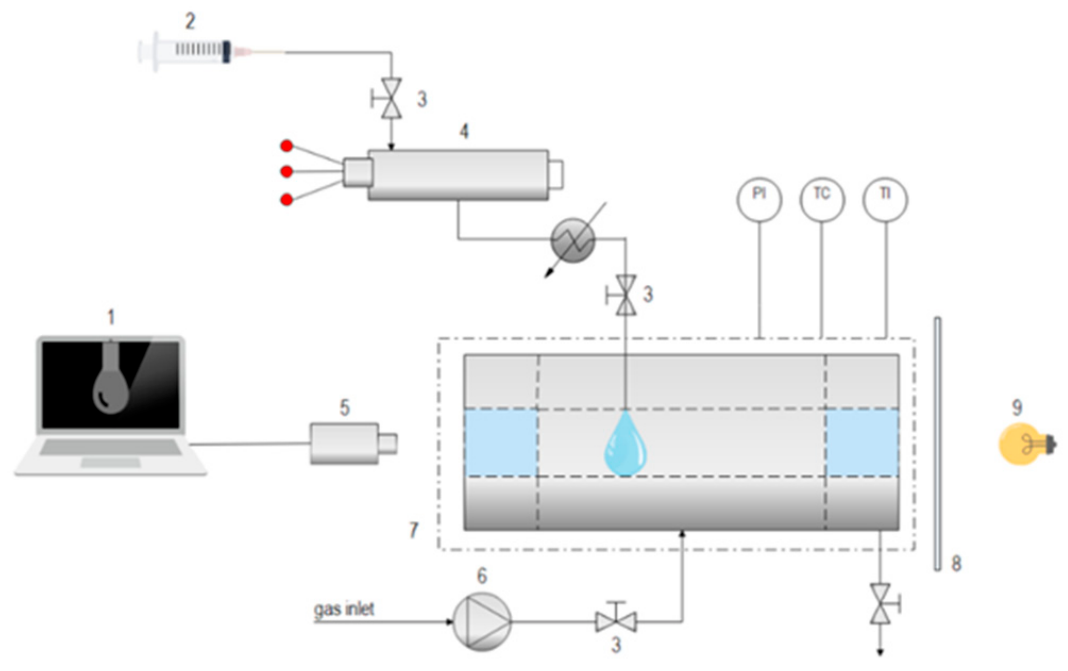
Figure 2. A scheme of a variable-volume high-pressure optical view cell for determination of interfacial tension of gas–alcohol systems; 1—computer, 2—injection needle, 3—valve, 4—manual pump, 5—CCD Basler camera, 6—high-pressure pump, 7—high-pressure optical view cell, 8—glass diffuser, 9—light source, PI—pressure indicator, TC—temperature controller, TI—temperature